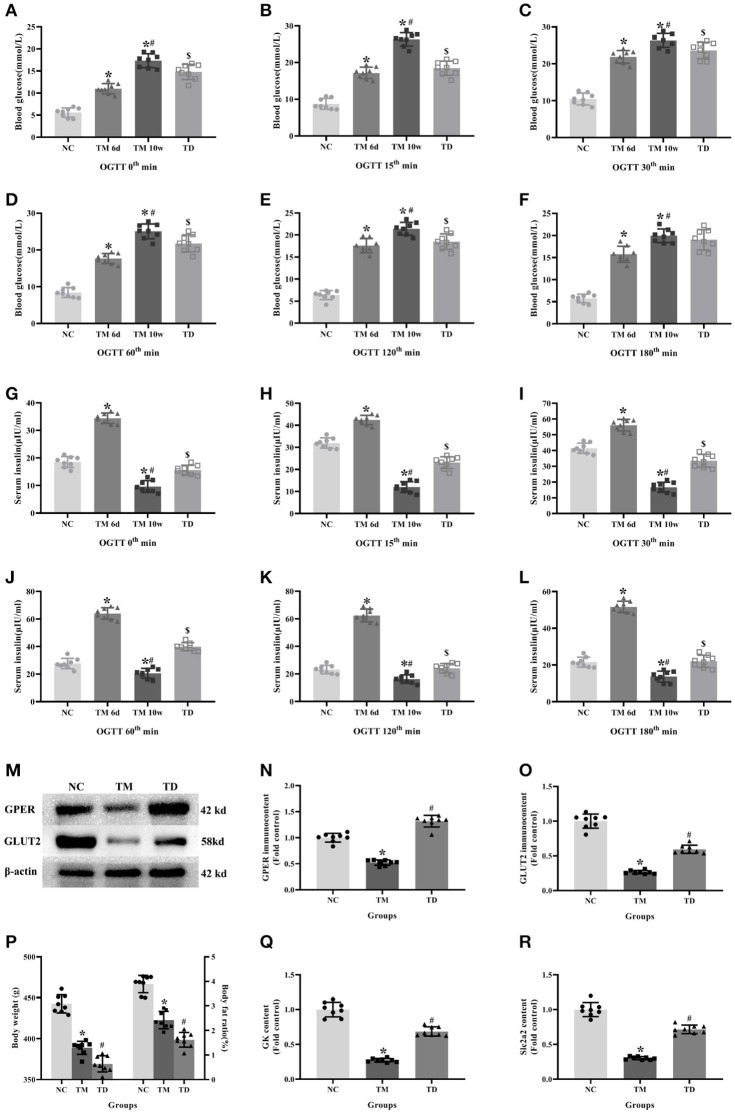
Effects of E2 on physiological indexes and biofactors in rats. (A–L) Blood glucose and insulin levels at different time point in OGTT. (M) Protein bands. (N,O) GPER and GLUT2 immunocontents, normalized to the internal control (β-actin). (P) Body weight and body fat ratios. (Q,R) Slc2a2 and GK contents. NC, the normal control group; TM 6d, the type 2 diabetes mellitus group 2 weeks after STZ injection; TM 10w, the type 2 diabetes mellitus group 10 weeks after STZ injection; TD, the type 2 diabetes mellitus drug-treatment group. (A–L,P)
n = 8 rats in each group. (M–O,Q,R). n = 8 rats in each group. n = randomly 3/8 rats in each group. Results of one-way ANOVA demonstrated *P < 0.05 compared to the NC group. #P < 0.05 compared to the TM 6d or TM groups. $P < 0.05 compared to the TM 10w group. Data were presented as the mean ± standard deviation.